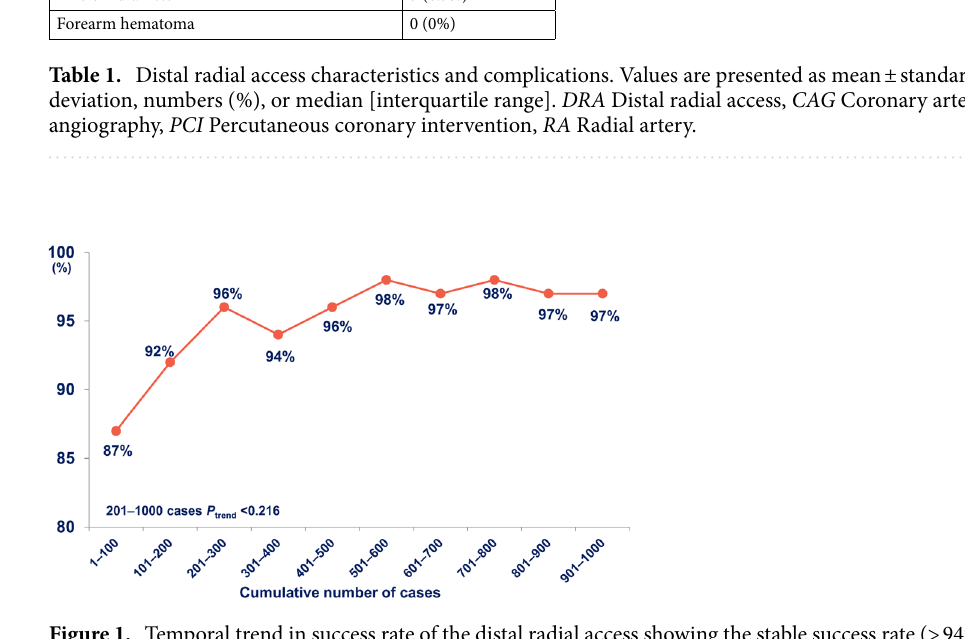
Figure 1. Temporal trend in success rate of the distal radial access showing the stable success rate (> 94%) after 200